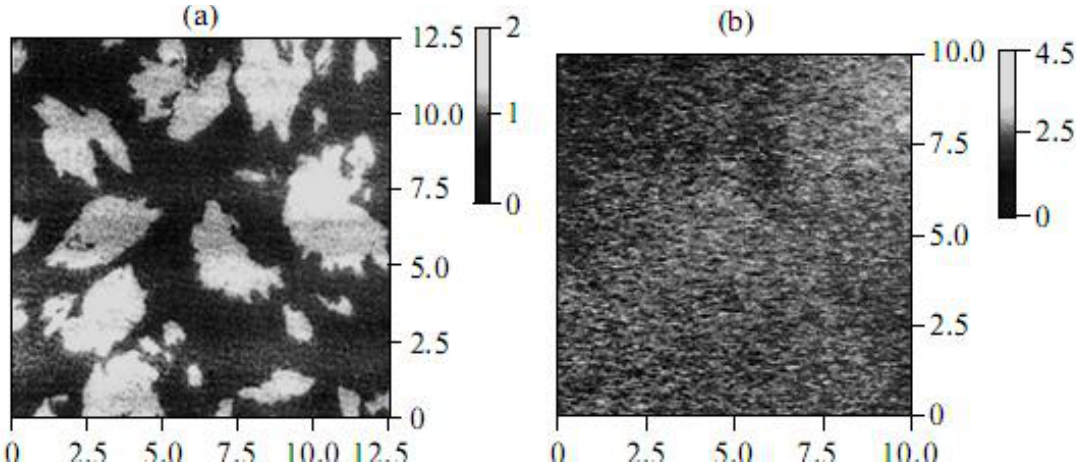
Figure 3. Atomic force micrographs of type-Ib CCD monolyers transferred by the Langmuir-Blodgett method onto a mica substrate from the surface of ( a ) water and ( b ) a 1 mM NaCl solution. In both panels, on the left is the structure of the object; on the right is the light scale characterizing the height of the objects in